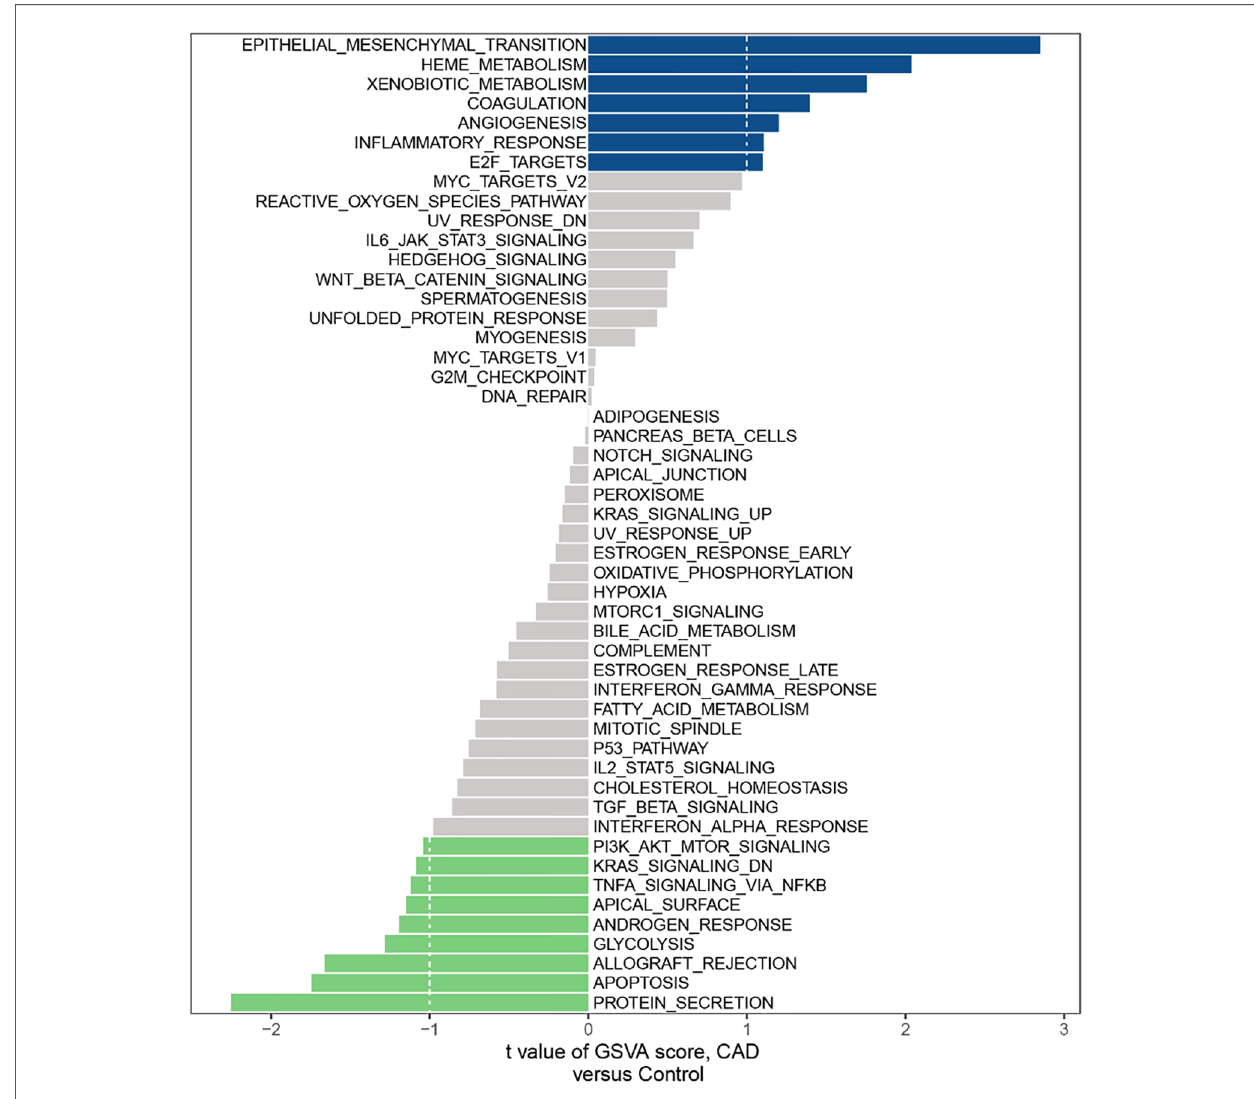
FIGURE 1 Hallmark gene set related to CAD in the GSE60681